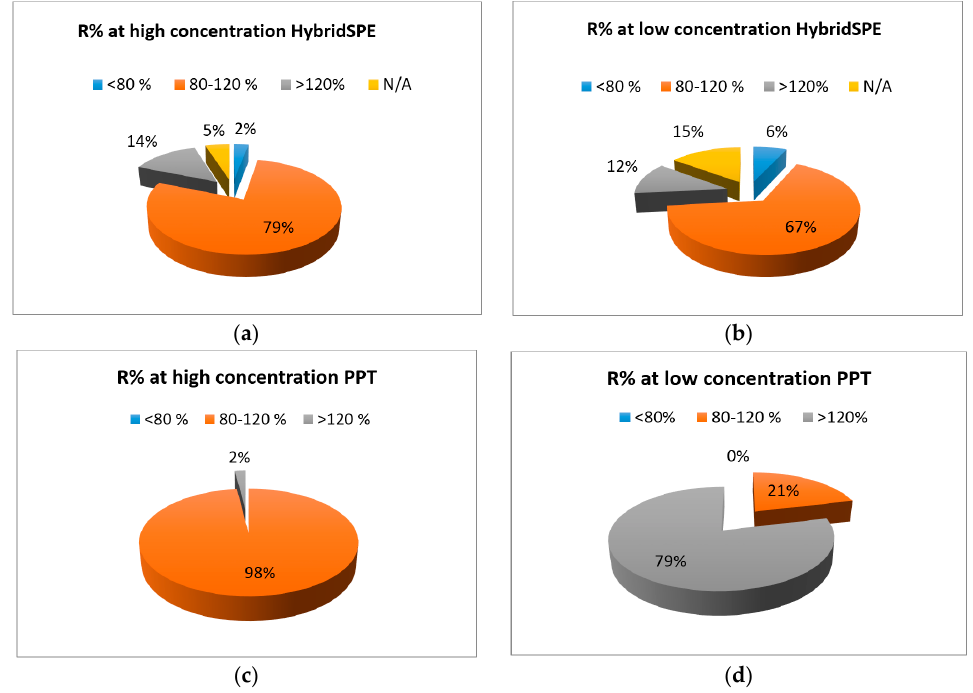
Figure 4. Distribution of recovery values for the 53 analytes under optimum HybridSPE conditions at ( a ) high and ( b ) low concentration. The respective recovery values for simple PPT are shown in ( c ) and ( d ) for high and low concentration in spiked pooled serum.